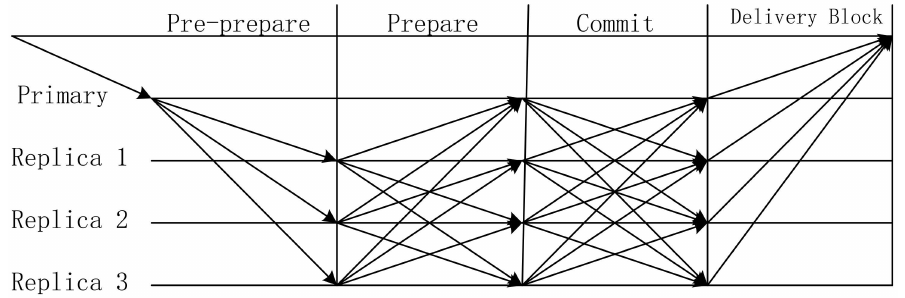
Figure 7. Consensus coordination group consensus